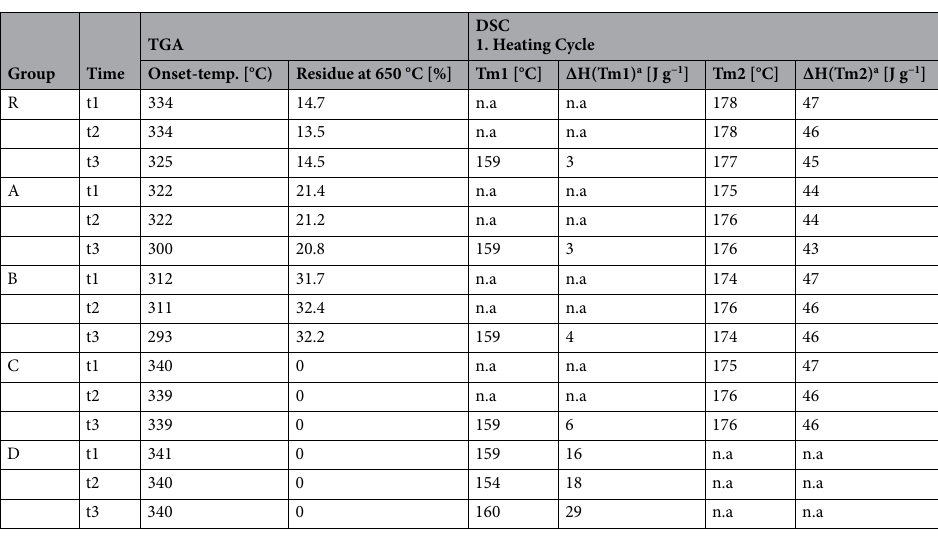
Table 2. TGA analyses of the evaluated groups. a ΔH corrected for filler content according to TGA residue at 650 °C.